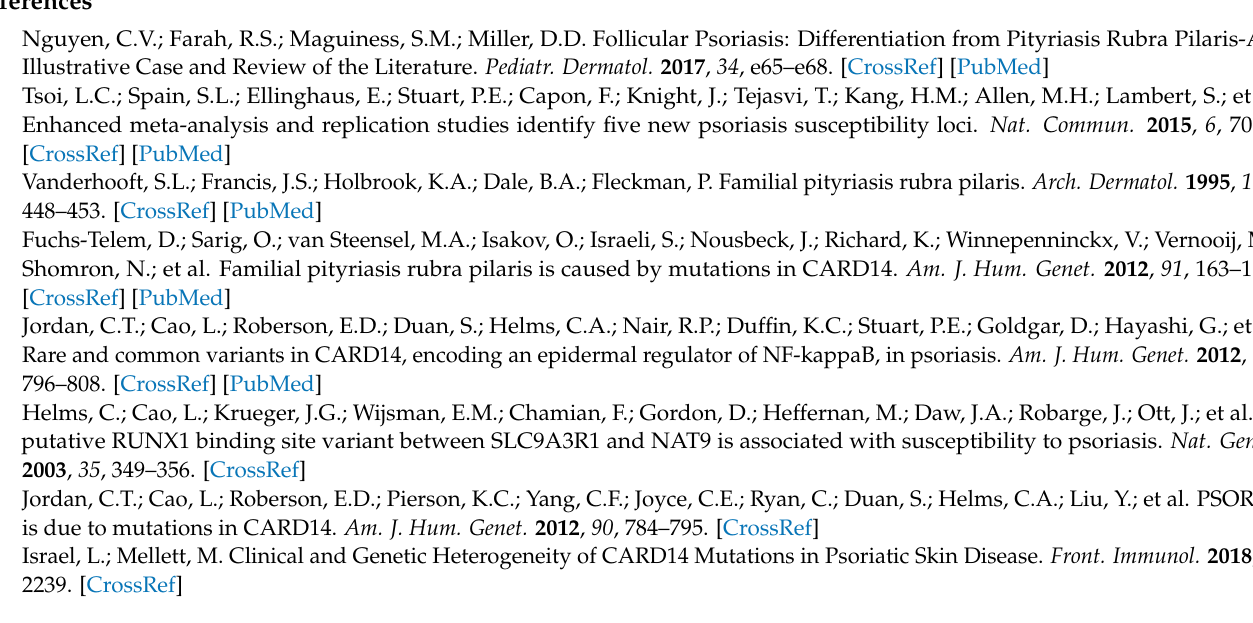
Table S2: Oligonucleotides used for